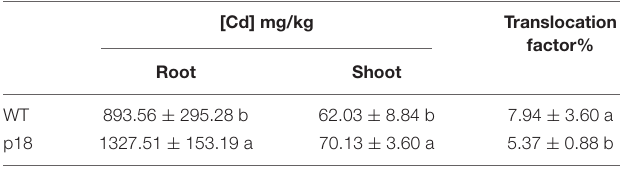
TABLE 1 | Cadmium content in roots and shoots of WT and transgenic p18 M. truncatula plants.